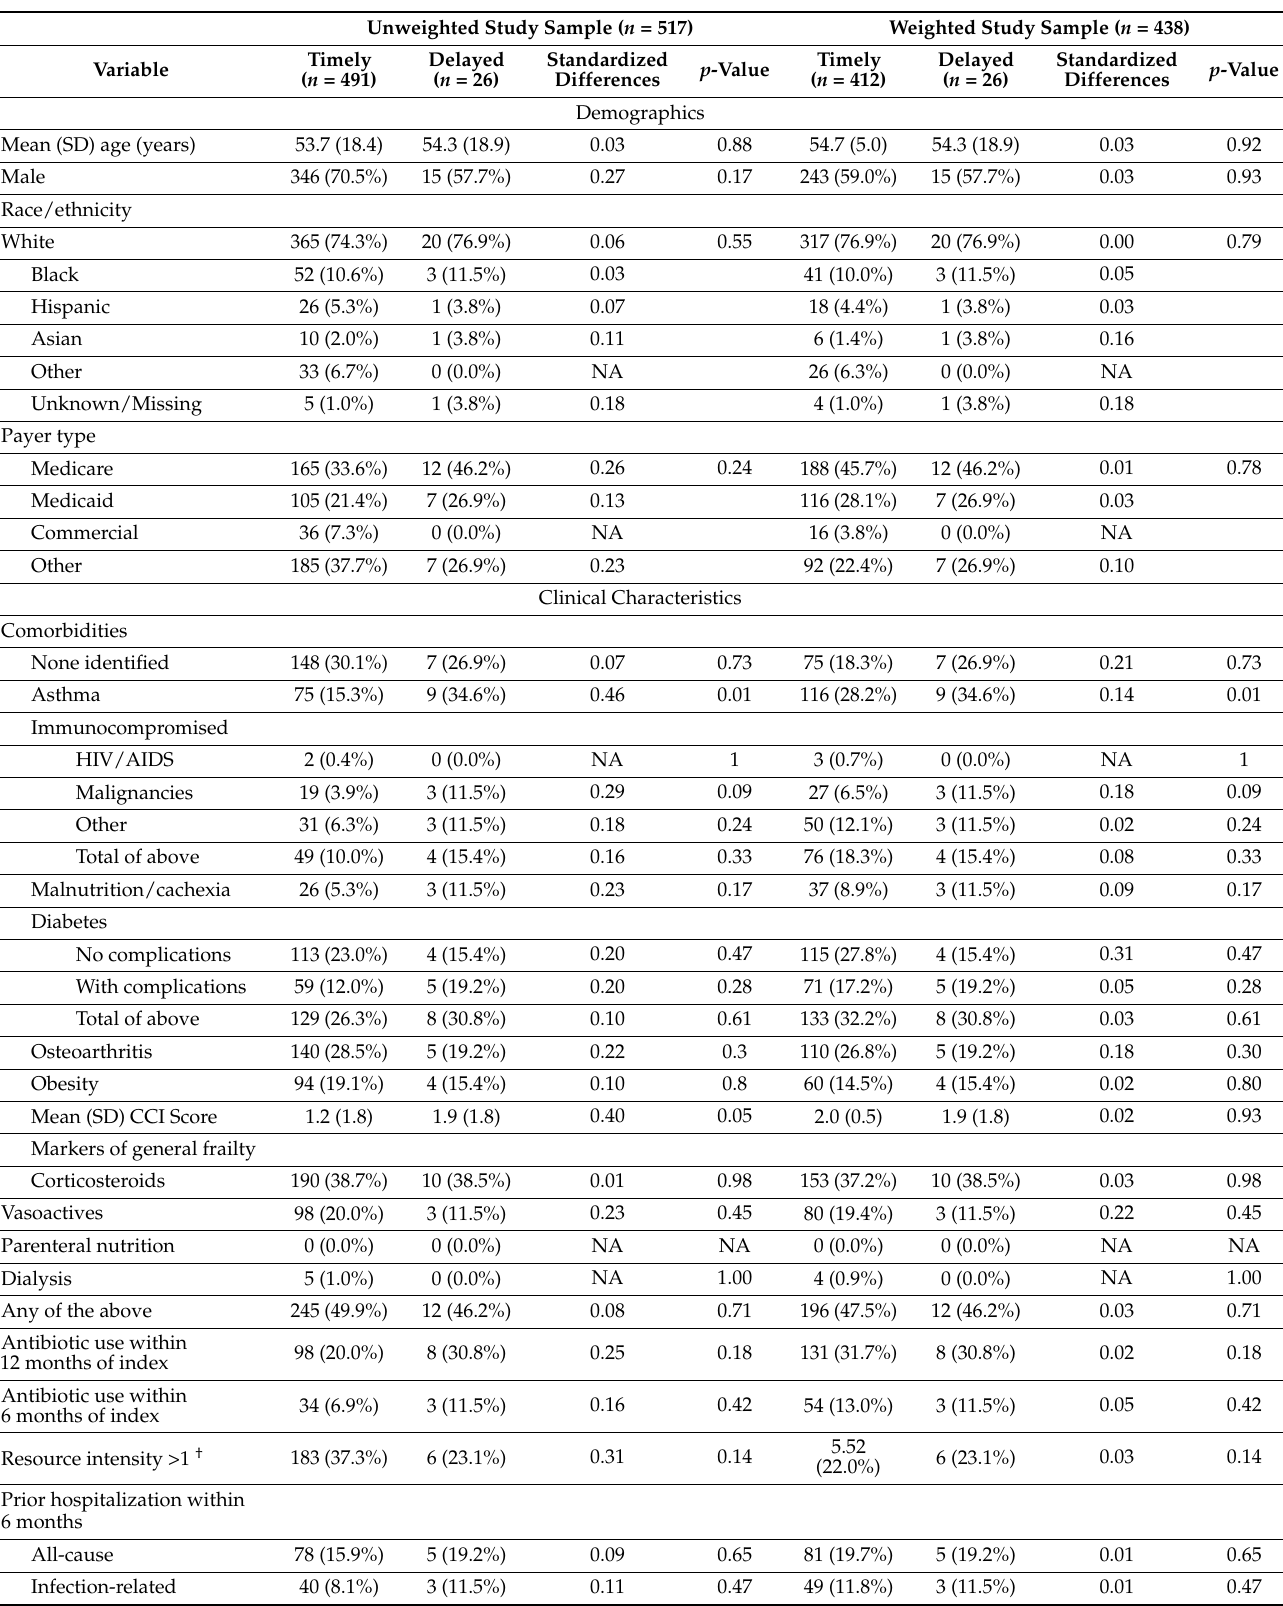
Table 3. Patient and hospital characteristics, by IPTW status and timing of appropriate therapy